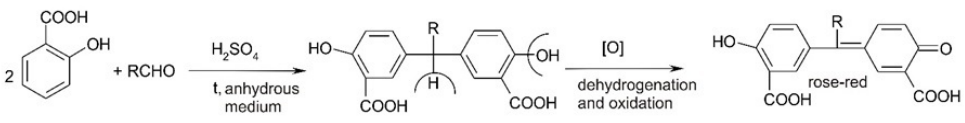
Fig. 1. Reaction of phenolic compounds with glucose.